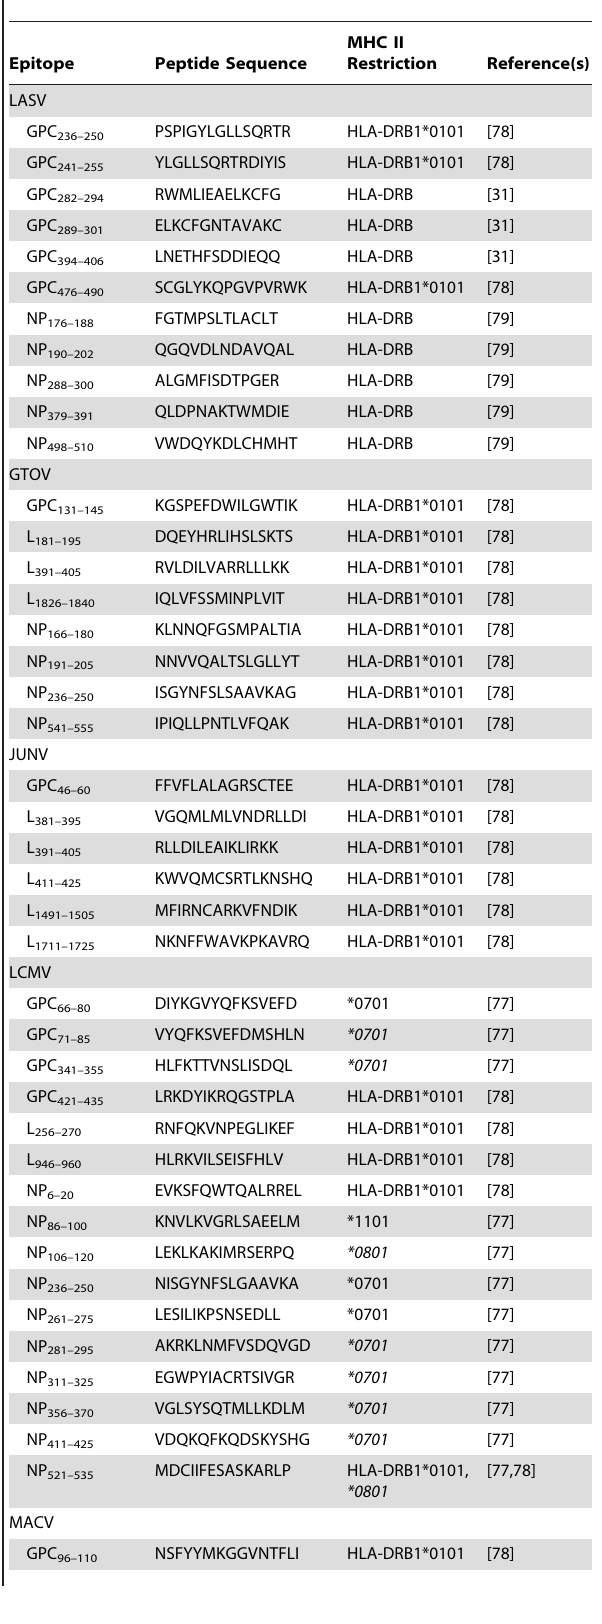
Table 2. Cont. Peptide